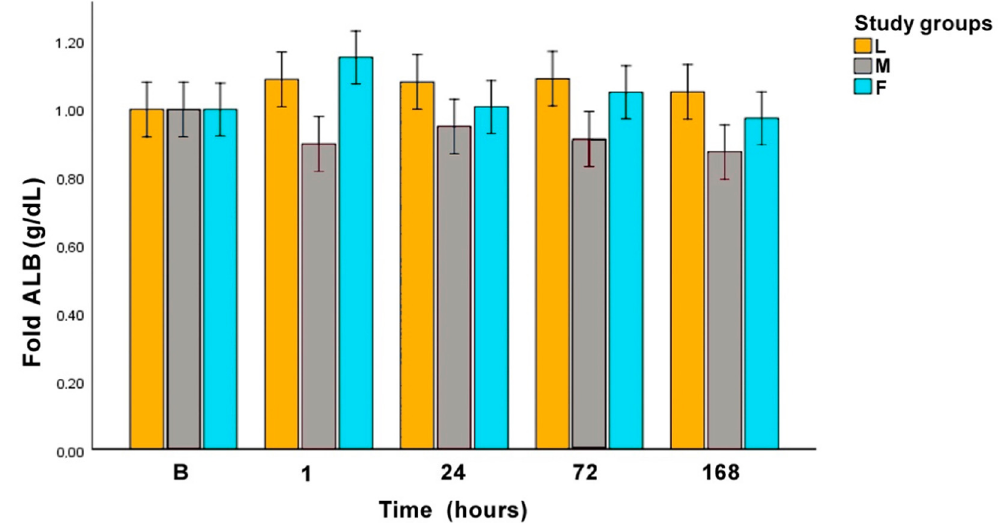
Figure 4. Fold albumin (Alb) concentration along the experimental period. L: laparoscopic OVE, M: midline OVE, and F: flank OVE. B: